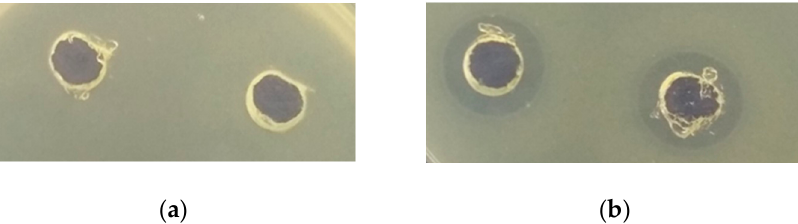
Figure 1. Antimicrobial effect of water-soluble protein fractions from quinoa fermented with L. plantarum MR24 against E. coli growth in agar plates. The clear zone of inhibition around the “well” indicates inhibition growth of E. coli : ( a )—non-hydrolysed protein fraction; ( b )—protein fraction hydrolysed with pepsin.